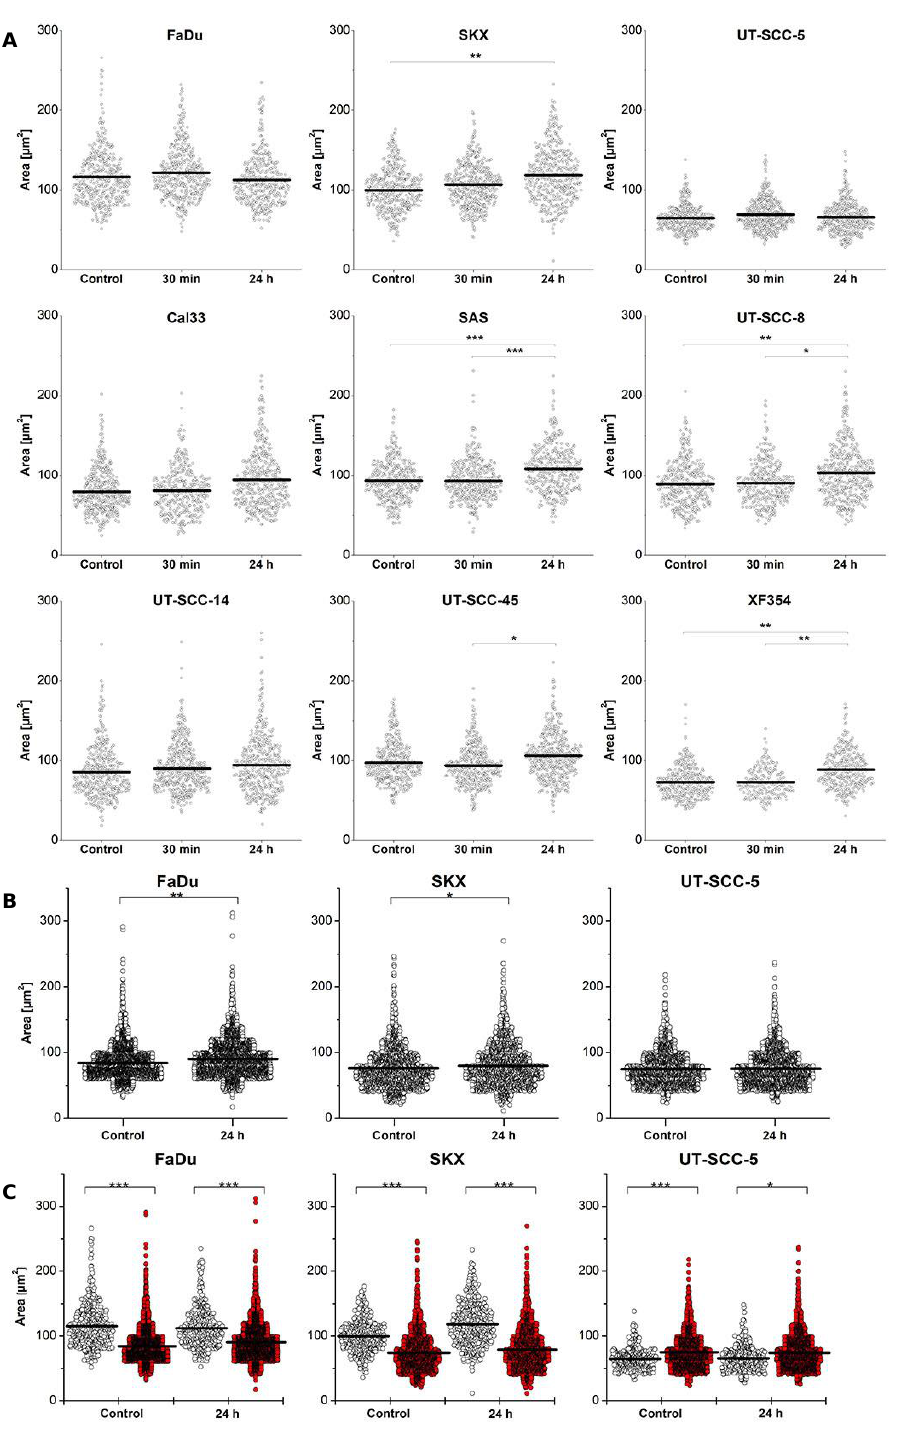
Figure 1. Impact of radiation exposure (4 Gy) and experimental setting (in vivo versus ex vivo) on nucleus area distribution. Scatter plots of nucleus areas from different hHNSCC xenograft models in vivo ( A ) and ex vivo ( B ). Comparison of nucleus areas between the experimental settings (open-circle: in vivo, red: ex vivo) in three hHNSCC tumor lines (FaDu, SKX, UT-SCC-5) ( C ). Nucleus areas were logarithmically transformed and fitted by a linear mixed-effects model (LMEM). Treatment conditions (control, 4 Gy exposure, time point post irradiation) or experimental settings (in vivo versus ex vivo) were defined as fixed effects; tumor, specimen, as well as region of interest (ROI) as random effects. Multiple pairwise comparisons (in vivo) with Bonferroni correction following LMEM analysis were performed. Solid bars represent means. (*: p < 0.05, **: p < 0.01, ***: p < 0.001). p values can be found in Supplementary Tables S2 and S3.